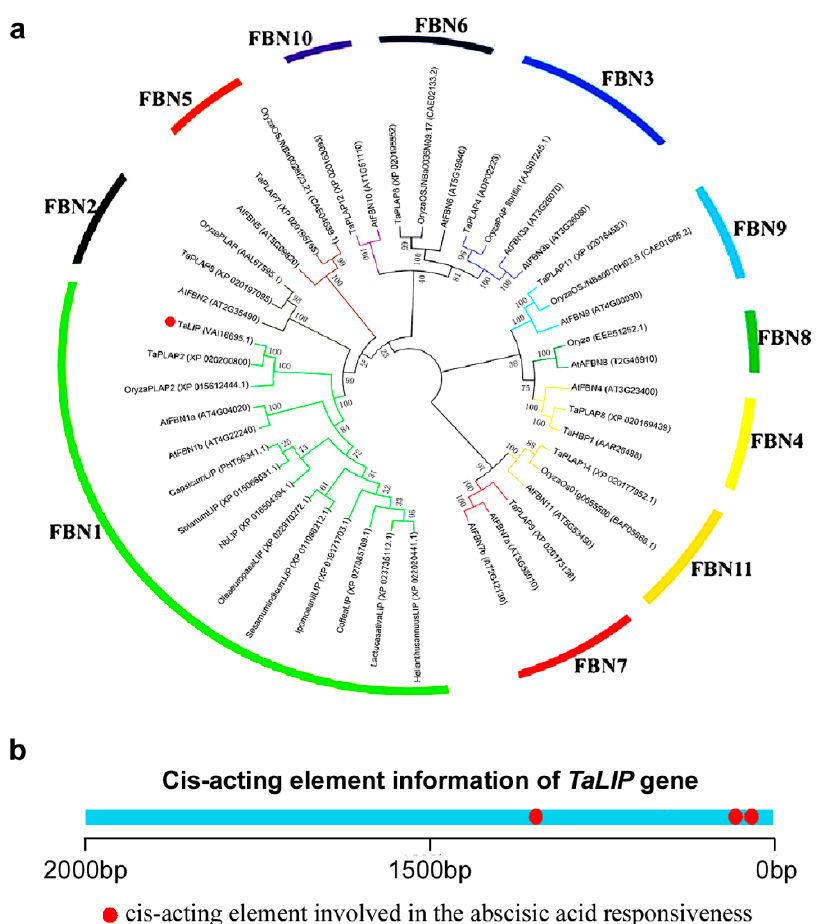
Figure 7. The Ta LIP protein belongs to the FBN1 (fibrillin family) and have three copies of the abscisic acid (ABA) responsive element. ( a ) Phylogenetic analysis of TaLIP and the construction of the evolutionary tree utilizing MEGA4 program [24]. The 11 distinct subfamilies were designated as 1~11 and labeled with different colored branches respectively. ( b ) promoter Cis-acting element prediction analysis of TaLIP .